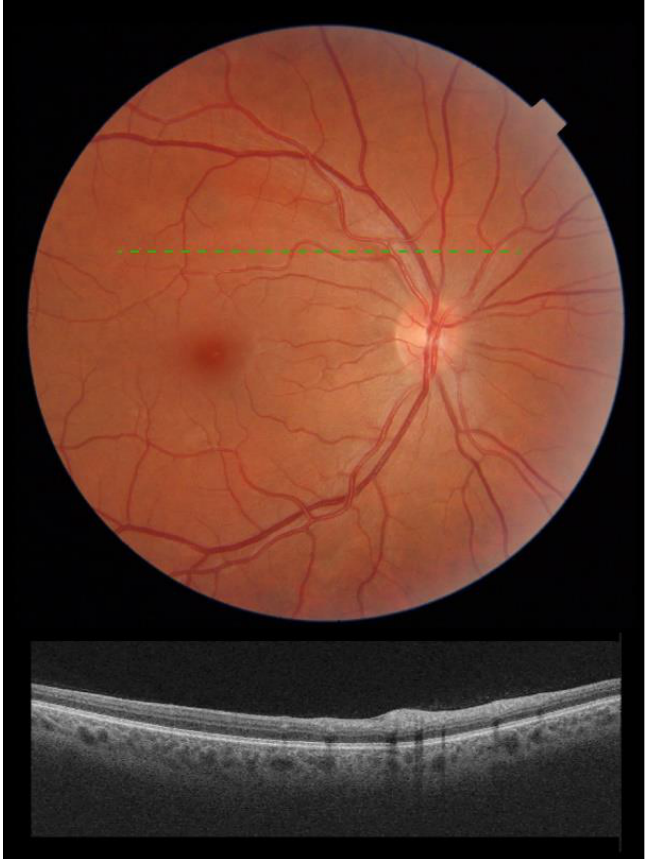
Figure 2. Composite figure. Color picture showing the right eye retina of a patient 3 months following admission to hospital with acute SARS-CoV-2 infection. The cotton wool spots detected at admission had subsided. No other signs of retinopathy could be detected ( top ). Optical Coherence Tomography scan over the area previously occupied by the cotton wool spot ( green dashed line ) showing normalization of the inner retinal architecture ( bottom ).